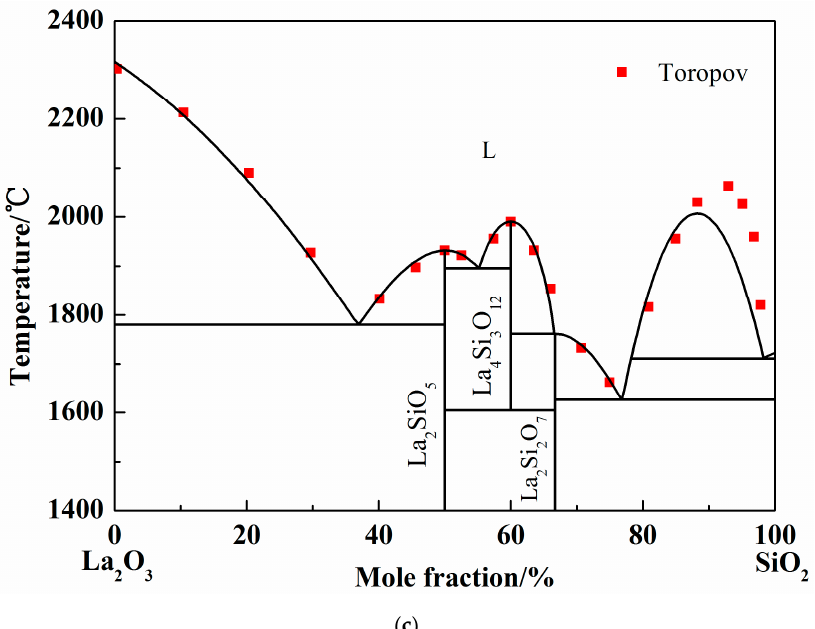
Figure 2. Calculated phase diagrams of binary systems. ( a ) Phase diagram of SiO 2 -Al 2 O 3 system; ( b ) Phase diagram of La 2 O 3 -Al 2 O 3 system; ( c ) Phase diagram of La 2 O 3 -SiO 2 system.